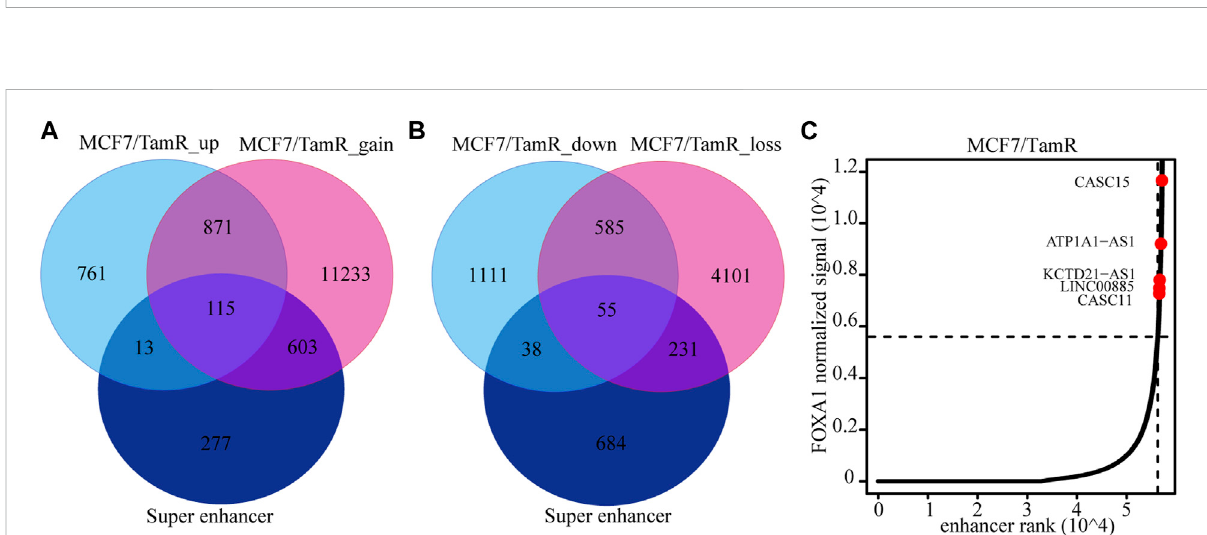
Theidenti fi edsuperenhancerassociatedlncRNAs. (A) ThevenndiagramoftheupregulatedRNAsinMCF7/TamR,FOXA1gainedreadsinMCF7/ TamR and super enhancer associated RNAs. (B) The venn diagram of the downregulated RNAs in MCF7/TamR, FOXA1 lost reads in MCF7/TamR and super enhancer associated RNAs. (C) Distribution of FOXA1 normalized ChIP-seq signal and the corresponding enhancer rank in MCF7/TamR cells, and red dot represents